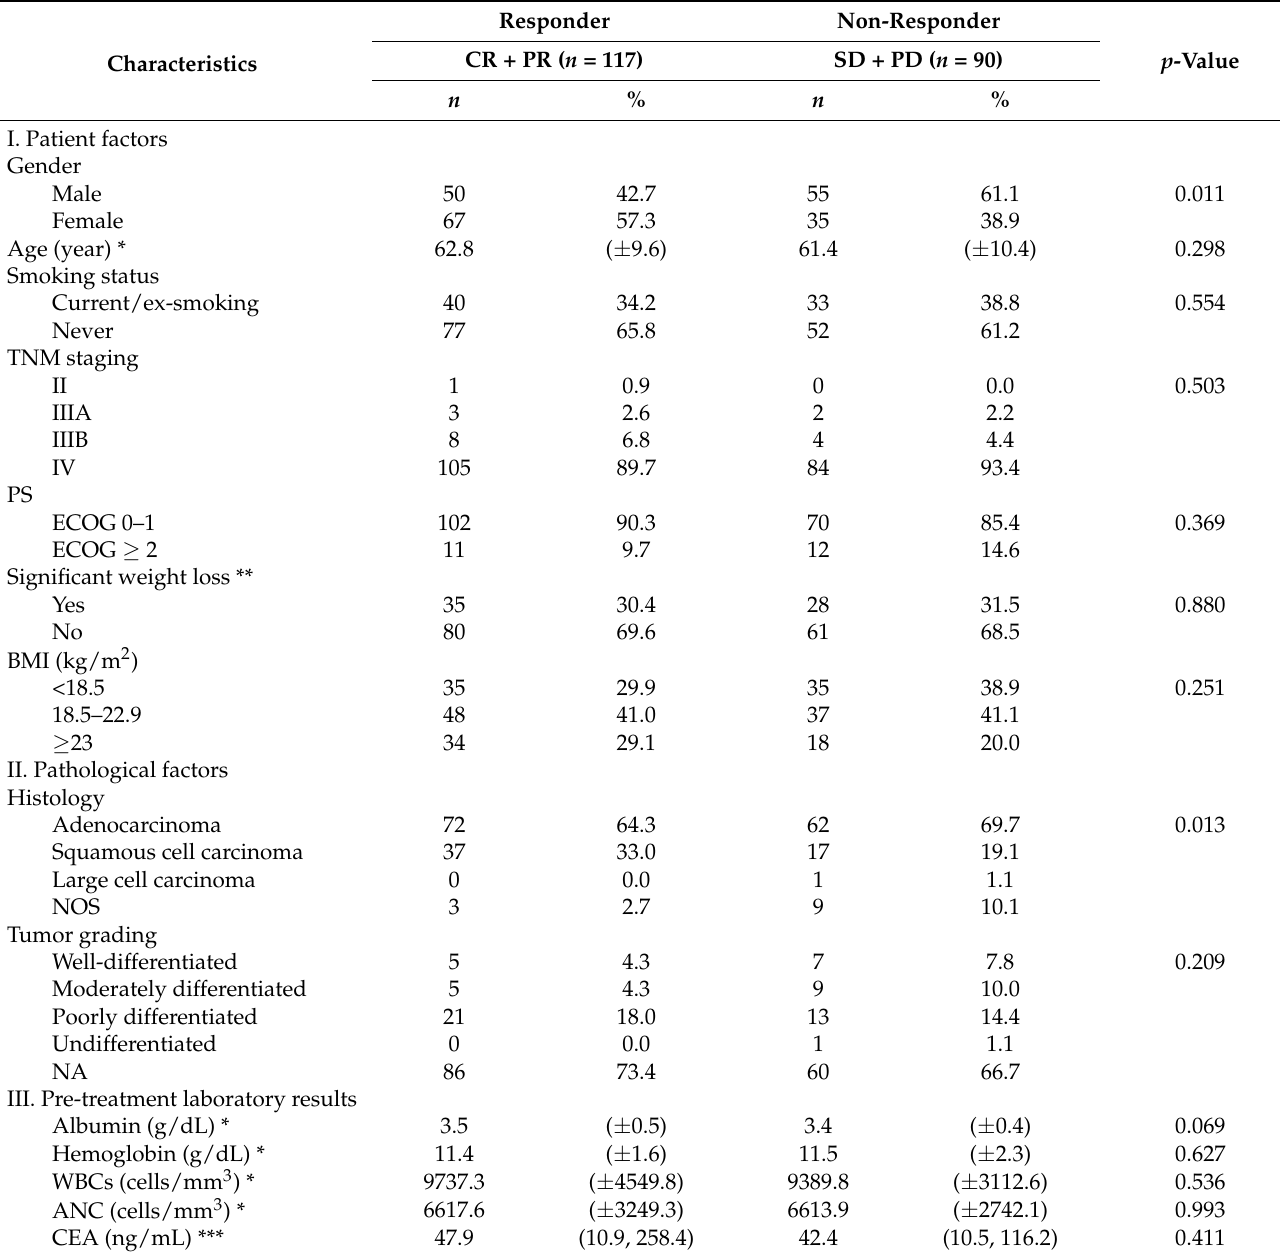
Table 1. Patient factors, pathological factors, and pre-treatment laboratory results of responder and non-responder groups (207